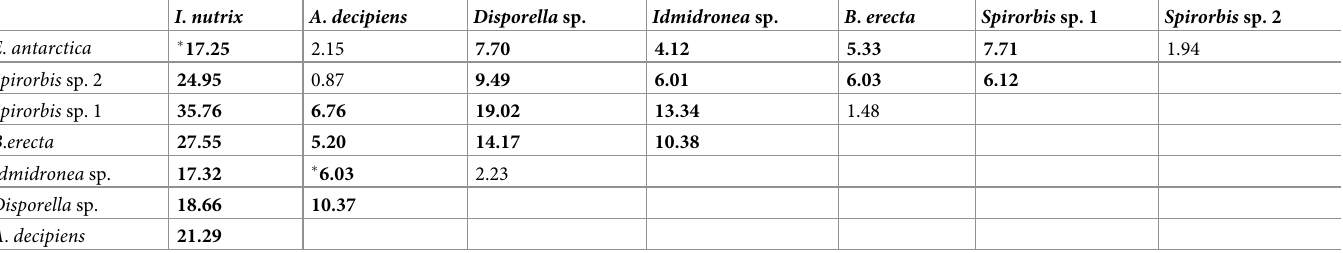
Table 4. Post hoc pairwise permutational multivariate analysis of variance (PERMANOVA) tests for differences in Mg content among species. PERMANOVA was done on untransformed skeletal Mg-calcite using a Euclidean distance similarity matrix. Values from t tests shown, with bold type indicates significant difference at p = 0.001, except where � p <